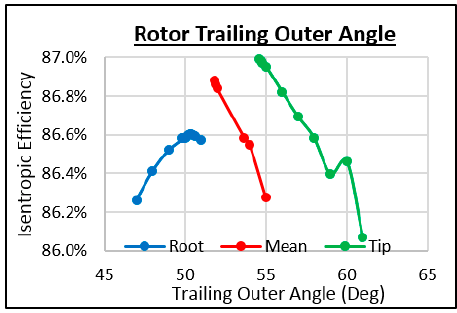
Figure 37. Study of the rotor trailing outer angle.